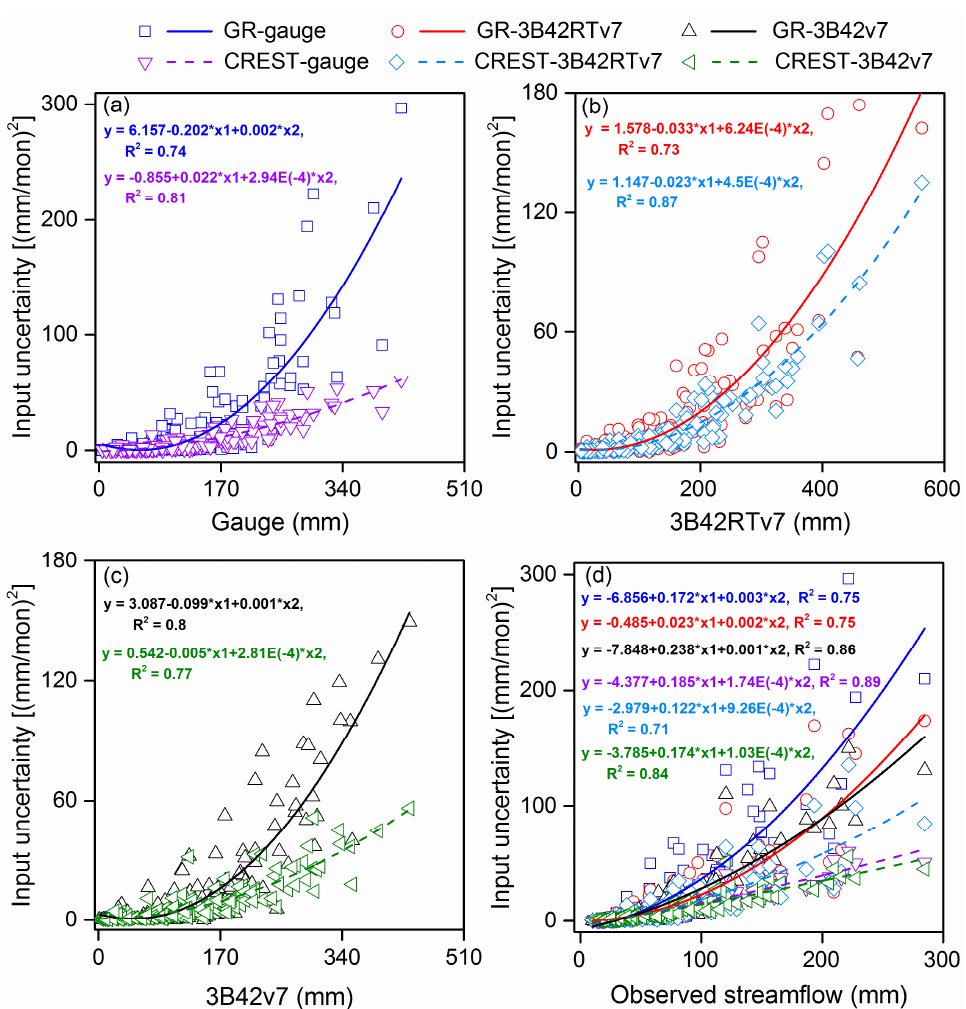
Figure 11. Scatter plots of input uncertainty against (a) gauge-based precipitation, (b) 3B42RTv7, (c) 3B42v7 and (d) the observed streamflow at monthly scale with the result of polynomial fitness.